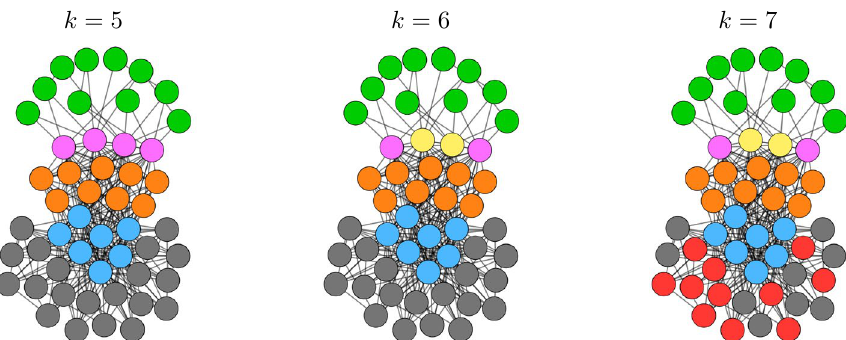
Figure 5. The evolution of the N = 50 node network with k ∗ = 5 true clusters depicted in Fig. 2. We apply a small perturbation (Type I, ǫ = 10 − 5 ). With each increase of k , the general structure of the partition is preserved, however existing clusters are